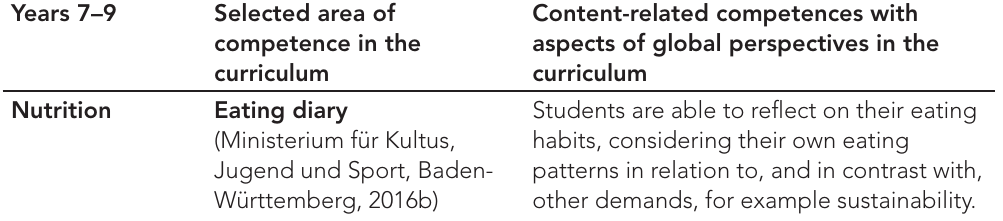
Table 1: Summary of content-related competences referring to global learning